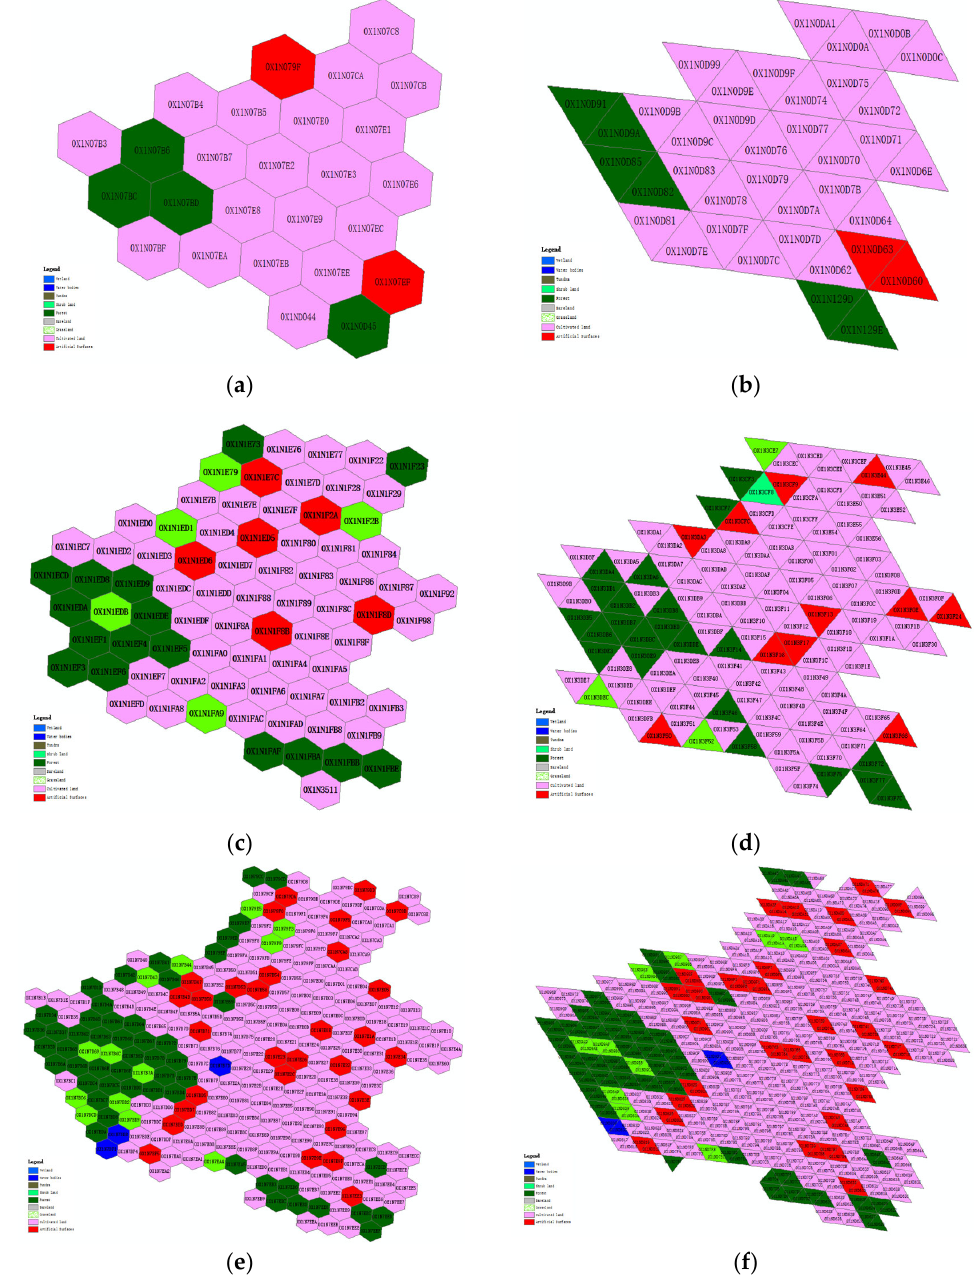
Figure 14. The different grid codes of the sixth, seventh and eighth levels of Globeland30 land coverage data in Henan Province before and after HtoTcode conversion. ( a ) The sixth level hexagonal grid code of land coverage data in Henan Province, ( b ) The sixth level HtoTcode triangle grid code of land coverage data in Henan Province, ( c ) The seventh level hexagonal grid code of land coverage data in Henan Province, ( d ) The seventh level Htotcode triangle grid code of land coverage data in Henan Province, ( e ) The eighth level hexagonal grid code of land coverage data in Henan Province, ( f ) The eighth level Htotcode triangle grid code of land coverage data in Henan Province.